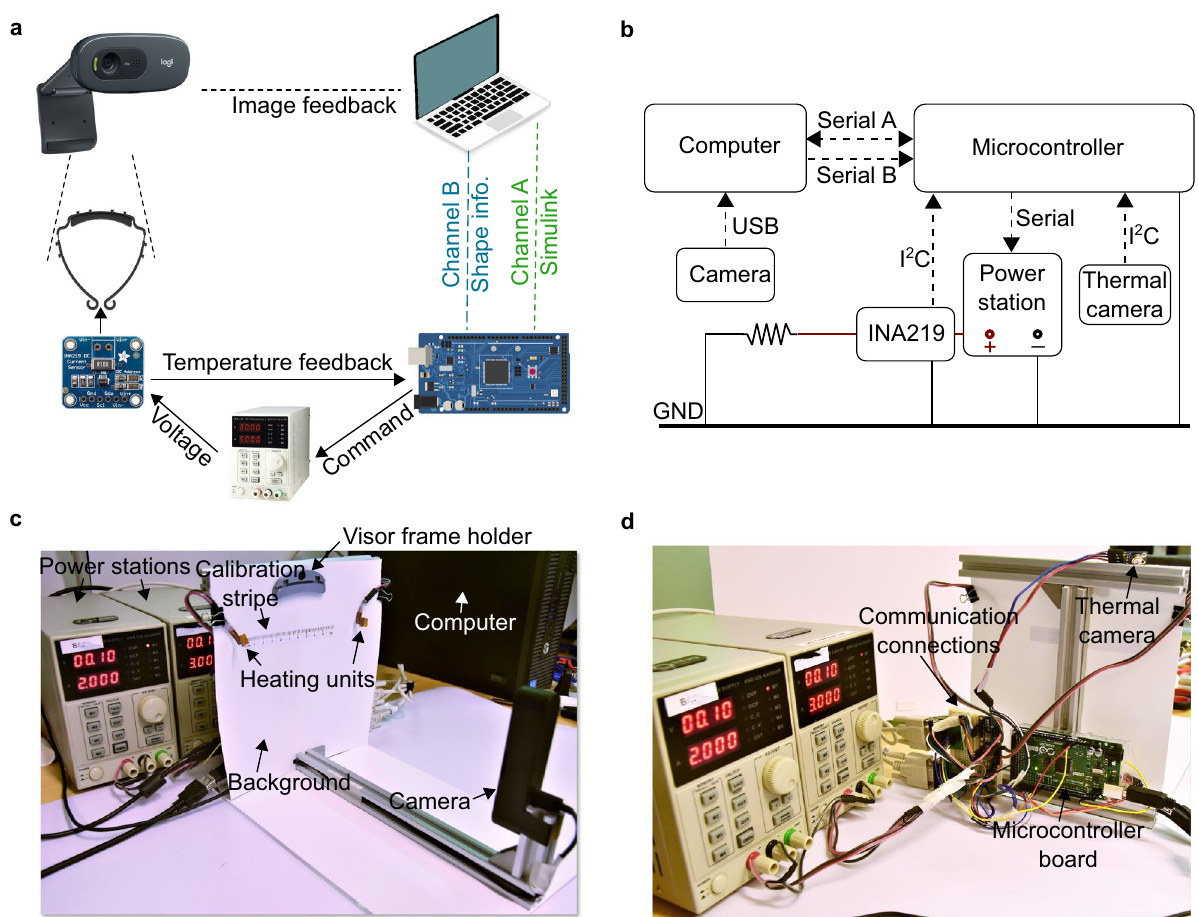
Figure 6. Experiment setup. ( a ) Connections for the experiment setup. ( b ) Schematics of the communications. ( c ) Front view of the experimental setup. ( d ) Back view of the experimental